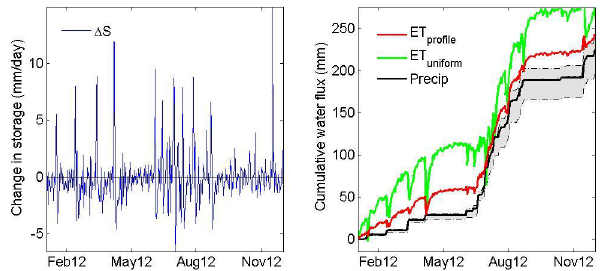
Fig. 10. Left: the change in soil moisture storage in mm per day. Right: cumulative distribution in time of precipitation (Precip), ET Figure 10. Left: The change in soil moisture storage in mm per day. Right: Cumulative 639 estimated from the soil moisture profiles (ET profile ) and uniform profile ET uniform . The abrupt decreases in cumulative ET is due to distribution in time of precipitation ( 𝑃𝑟𝑒𝑐𝑖𝑝 ), ET estimated from the soil moisture profiles 640 a time discrepancy between precipitation events and daily average ( 𝐸𝑇 𝑝𝑟𝑜𝑓𝑖𝑙𝑒 ) and uniform profile 𝐸𝑇 𝑢𝑛𝑖𝑓𝑜𝑟𝑚 . The abrupt decreases in cumulative ET is due to a 641 soil moisture time discrepancy between precipitation events and daily average soil moisture values. 642